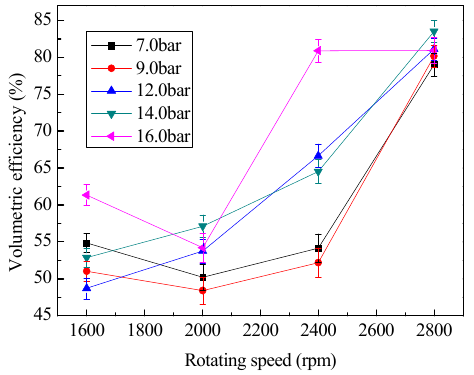
Figure 7. Volumetric efficiency versus rotating speed.